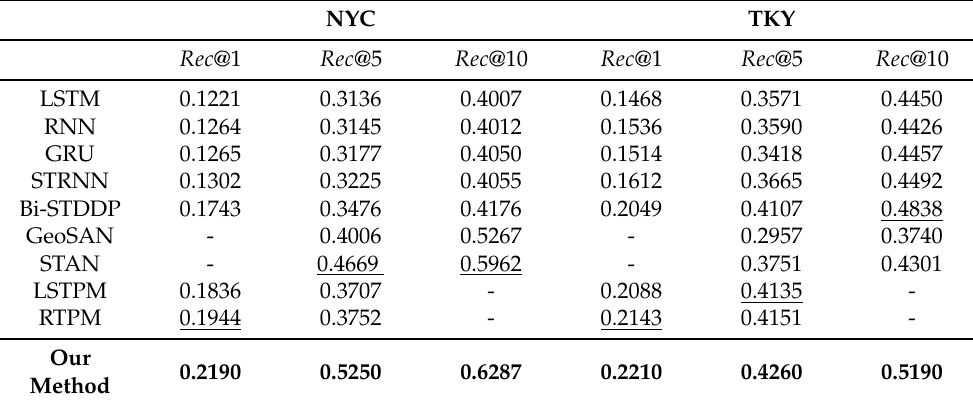
Table 2. Recommended performance